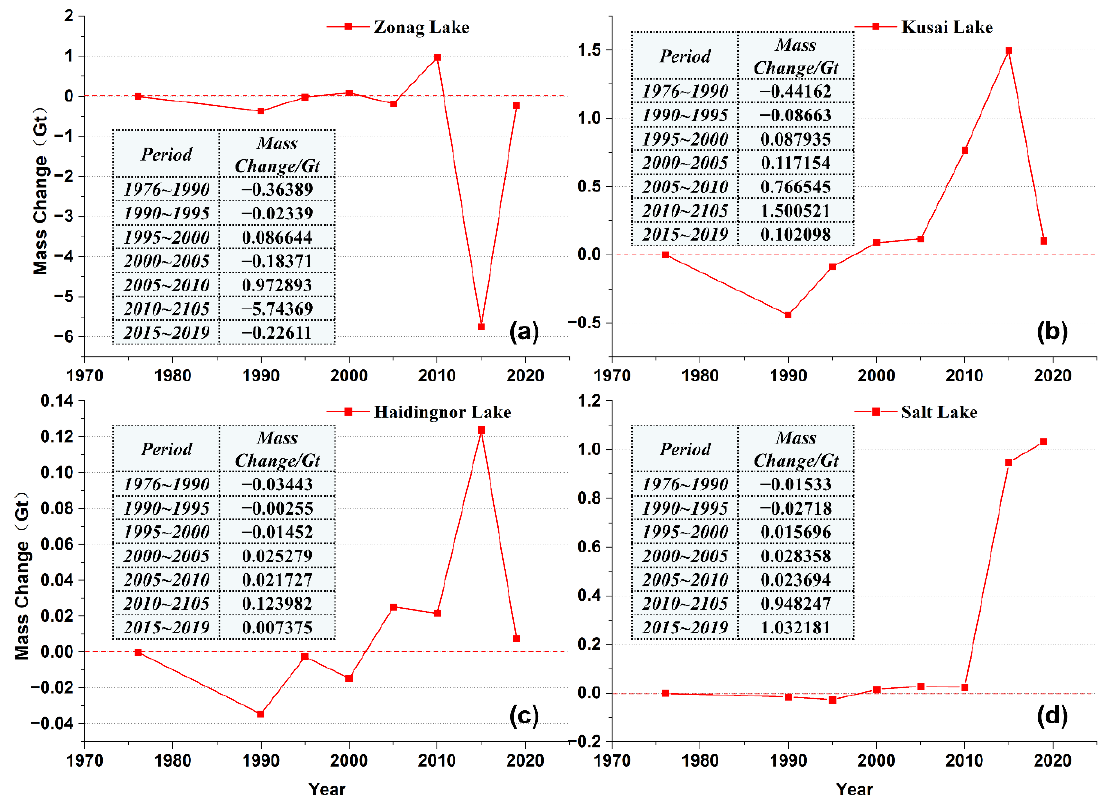
Figure 7. Mass changes of ( a ) Zonag Lake; ( b ) Kusai Lake; ( c ) Haidingnor Lake; and ( d ) Salt Lake between 1976 and 2019.